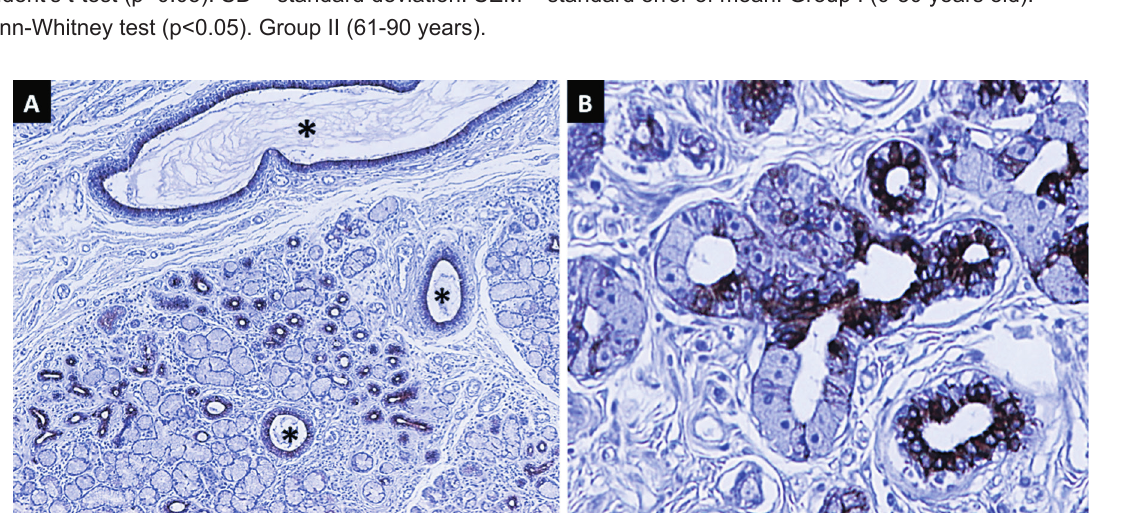
Figure 4- A: Similar CK 19 expression between ducts (*) and duct-like structures (Group II). B: Mixed structure with ductal and acinar cells. The ductal cells are stained with the anti- CK 19 (Group